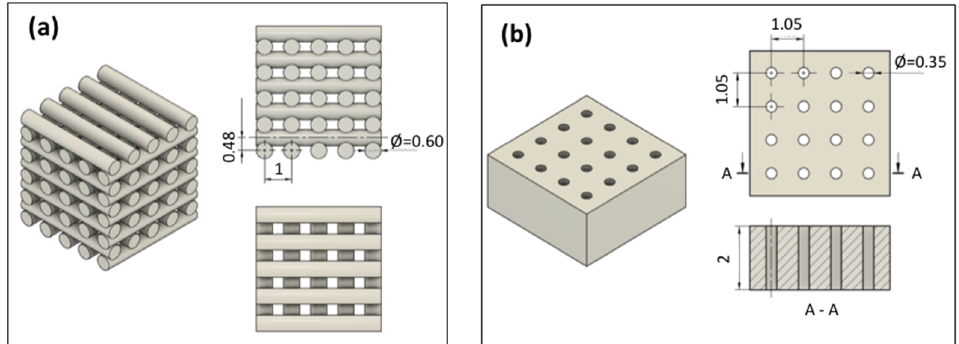
Figure 13. Design section views of the scaffold shapes and its corresponding pore structure: ( a ) layer-by-layer of the interconnected macroporous pattern planned by using robocasting; ( b ) arrangement of the cylindrical holes for a macroporous structure generated by applying laser ablation in a rectangular prism monolith composite. All dimensions are presented in mm.